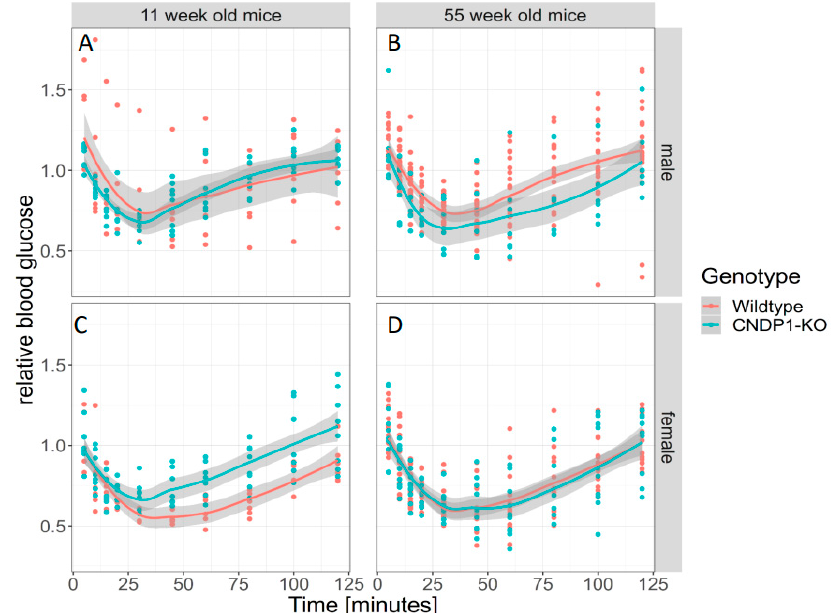
Figure 8. Intraperitoneal Insulin Tolerance Test (IP-ITT) in 11-week-old male ( A ) and female ( C ) Cndp1 -KO and WT mice and in 55-week-old male ( B ) and female ( D ) Cndp1 -KO and WT mice. Blood glucose levels are given relative to basal blood glucose level. In generalized additive mixed models (GAMM) analysis, gender ( p = 0.027) but not the genotype predicted blood glucose levels following insulin injection, with higher values in female Cndp1 -KO mice. (11 weeks male Cndp1 -KO: n = 7; 11 weeks male WT: n = 8; 11 weeks female Cndp1- KO: n = 6; 11 weeks female WT: n = 8; 55 weeks male Cndp 1-KO: n = 21; 55 weeks male WT: n = 7; 55 weeks old Cndp1- KO female: n = 15; 55 weeks old female WT: n = 10). Intraperitoneal glucose tolerance tests (IP-GTT) performed at age of 11 and 55 weeks resulted in Int. J. Mol. Sci. 2020 , 21 , x FOR PEER REVIEW similar increased blood glucose concentrations relative to baseline blood glucose in both gender and genotypes over 120 min (Figure 9). GAMM analysis did neither reveal an effect of genotype nor of gender on blood glucose levels over 120 min of IP-GTT at weeks 11 and 55. Plasma insulin concentrations determined at week 55 were higher in WT male vs. female mice (male WT: 1.61 ± 0.2 vs. female WT: 0.92 ± 0.29, p = 0.025; male Cndp1-KO: 1.93 ± 0.92 vs. female Cndp1- KO 1.36 ± 1.15; p = 0.6) and not different between WT and Cndp1-KO mice (WT: 1.27 ± 0.43; Cndp1- KO: 1.59 ± 0.99; p = 0.48).